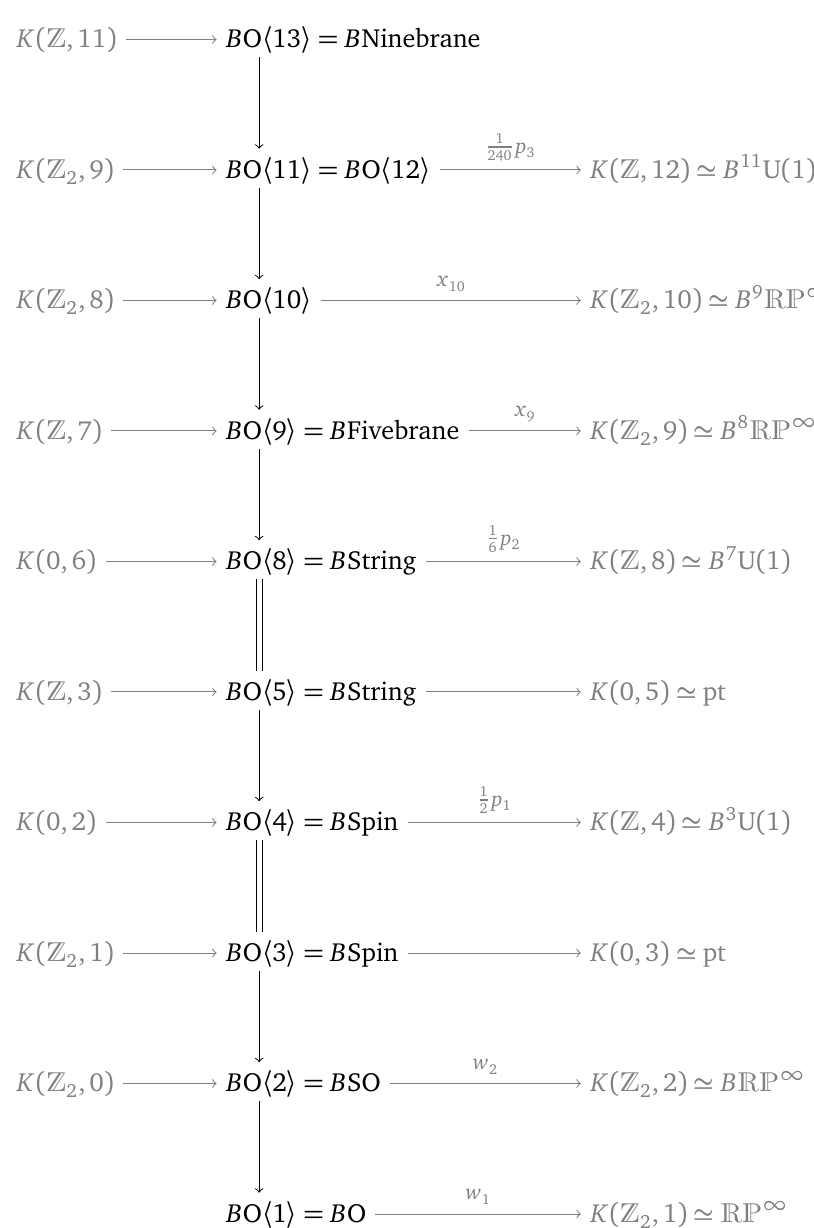
Figure 1: The first twelve floors of the Whitehead tower of B O, including the ( B O ) , n − 2 ) as the fibres of the fibrations Eilenberg–Mac Lane spaces K ( π n − 1 ( B O ) , n ) encoding B O 〈 n + 1 〉 −→ B O 〈 n 〉 on the left, and the maps B O 〈 n 〉 −→ K ( π n the obstructions to lifting O 〈 n − 1 〉 -structures to O 〈 n 〉 -structures on the